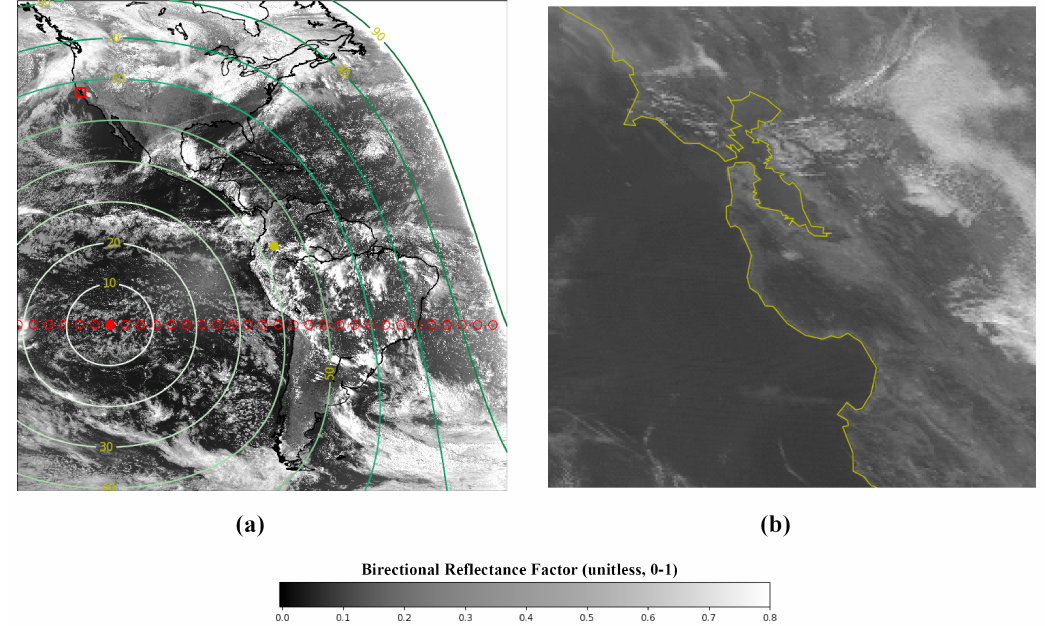
Figure 9. TOA Bidirectional Reflectance Factor (BRF) of Band 2 of ABI on 2018/01/23, 19:45 UTC. The data were geocorrected and reprojected onto the GeoNEX common grid. Panel ( a ) shows the BRF over the 120 ◦ × 120 ◦ domain of GOES 16. The yellow circle indicates the subpoint of GOES 16. The solid red circle indicates the subpoint of the Sun at the nominal acquisition time (23 January 2018, 19:45 UTC), and the open red circles show the trace of the solar subpoints during the day at 15 min time steps. The green contour lines indicate the variation of solar zenith angles at an interval of 10 ◦ across the domain. Panel ( b ) shows an enlarged image of the area (San Francisco Bay) marked by the red rectangle in Panel ( a ).